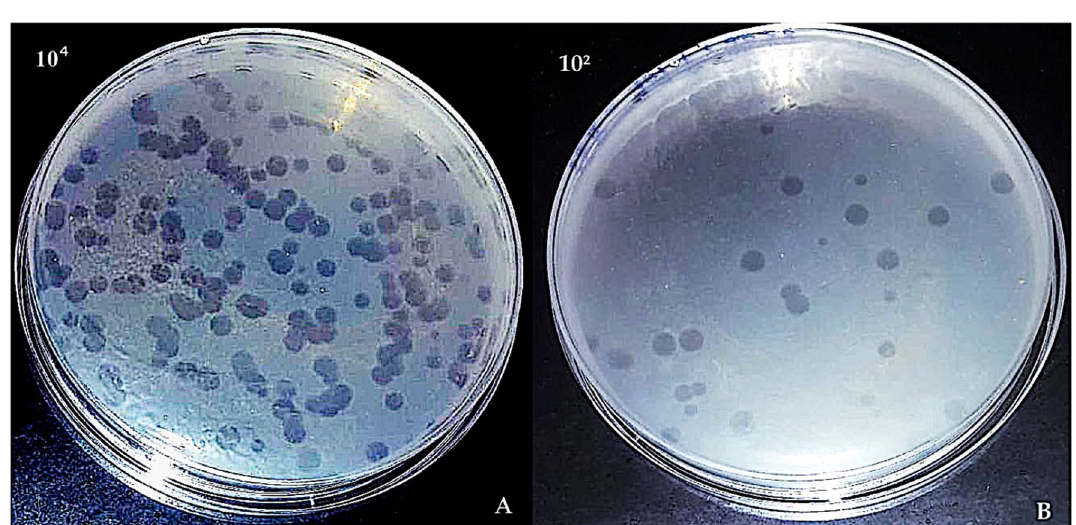
Figure 3. A schematic view of lysed plaques (3–4 nm) on Middlebrook (MB) 7H10 agar corresponding to MAP concentrations of 10 4 ( A ) and 10 2 ( B ) cfu/mL in an artificially contaminated milk sample (this photo was taken before the end of the overnight incubation (18-h) at 37